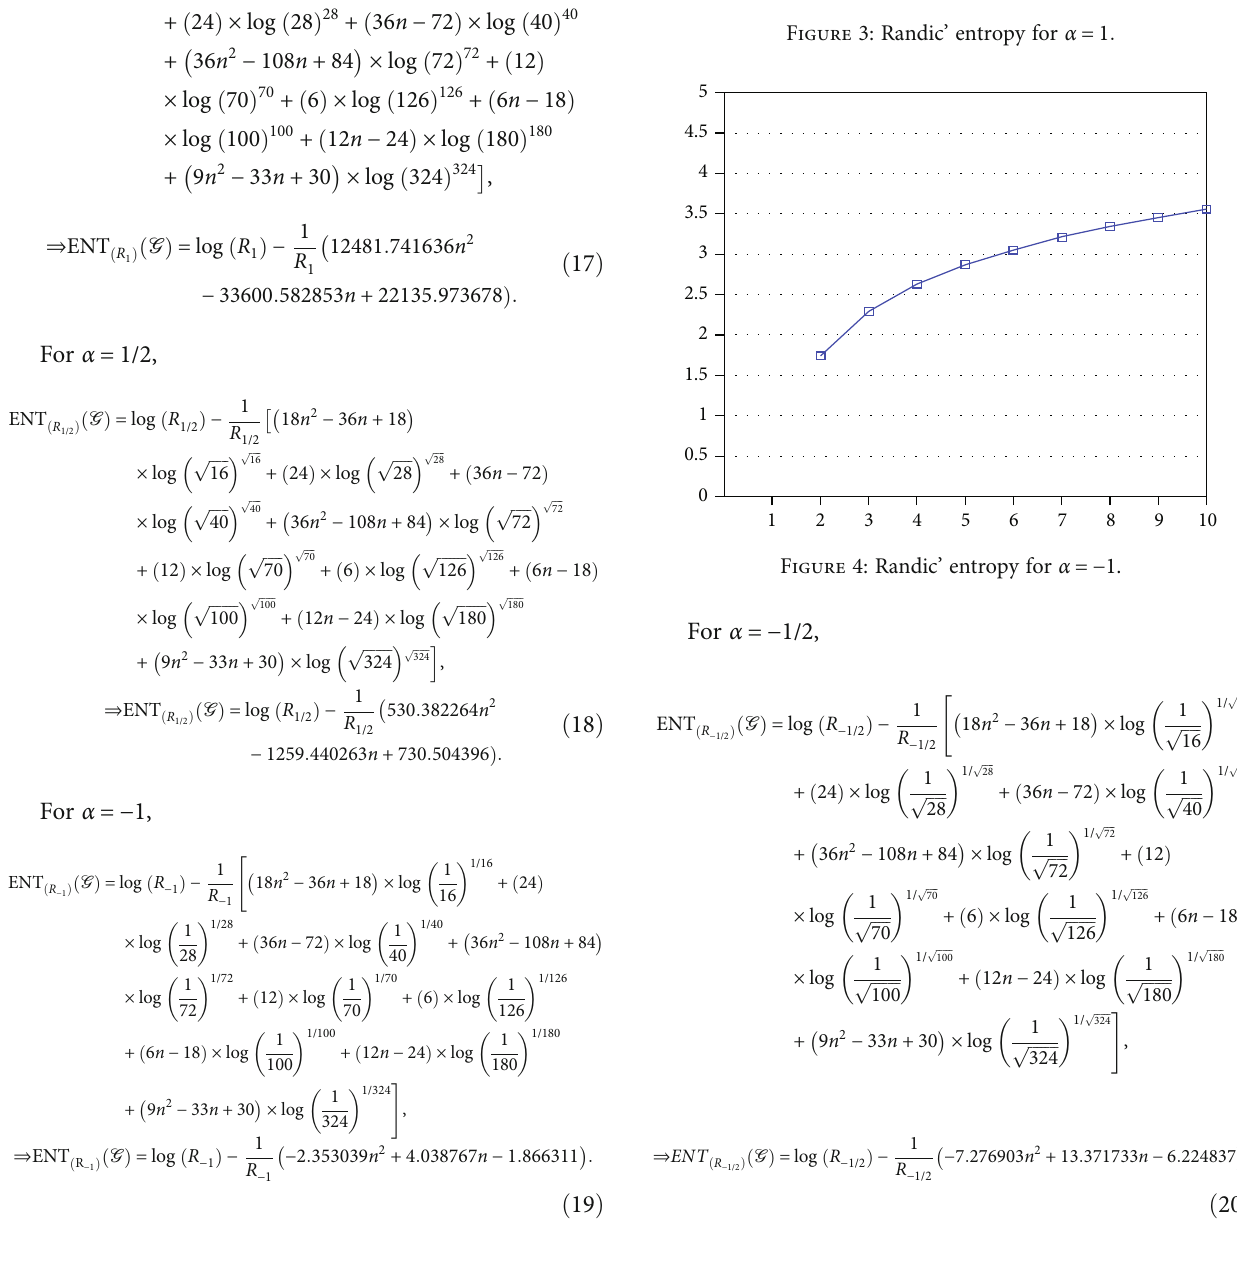
Figure 3: Randic ’ entropy for α = 1 :